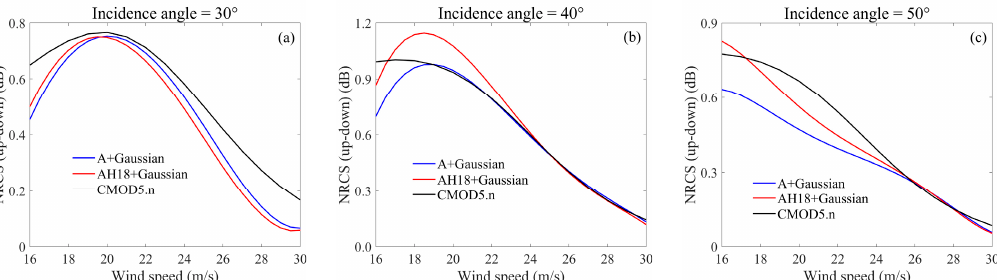
Figure 12. Upwind–downwind asymmetry predicted by the modified TSM with A + Gaussian and AH18 + Gaussian input at high wind speeds, and their comparison with CMOD5.n as functions of wind speed ( a ) at incidence angle of 30 ◦ , ( b ) at incidence angle of 40 ◦ , and ( c ) at incidence angle of 50 ◦